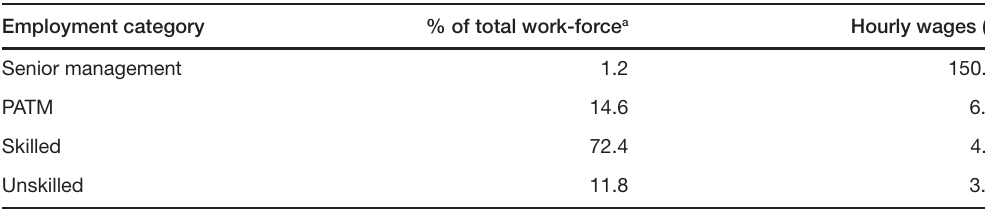
Table 3. Distribution of workforce and wage rate.